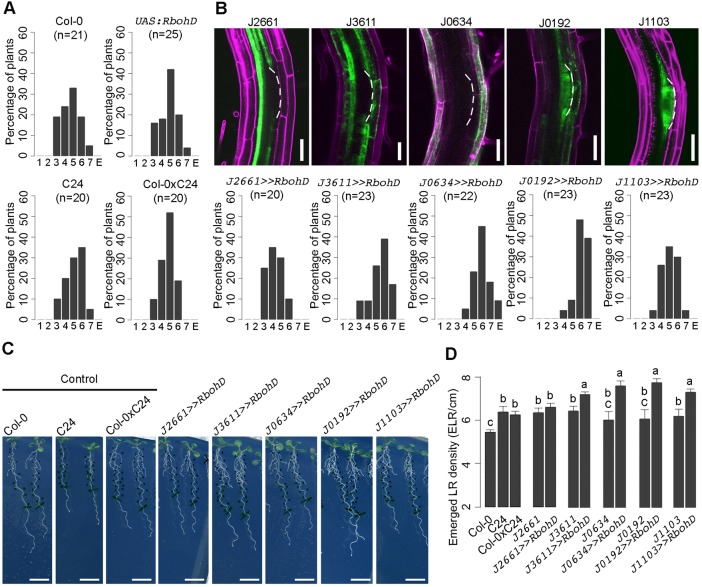
The effect of tissue-specific overexpression of RBOHD on LR development. (A) LR emergence phenotype of control lines. Five-day-old seedlings were transferred onto new media and gravistimulated by 90° to achieve synchronization of LR formation. LRP were grouped according to developmental stages at 44 h after the onset of gravistimulation. Data points represent mean±c.i. (technical replicates). E, emerged LR. (B) Expression pattern of GAL4 transactivation lines (upper panels) and LR emergence phenotype of UAS:RBOHD targeted to the corresponding GAL4 transactivation lines, as indicated. Scale bars: 50 μm. (C) Representative root phenotypes of 10-day-old seedlings. (D) Emerged LR number of control and tissue-specific transactivation lines of UAS:RBOHD. Data points represent mean±c.i. (technical replicates, n=20). The difference between groups denoted by different letters is statistically significant (P<0.001 according to Tukey's HSD test after ANOVA).